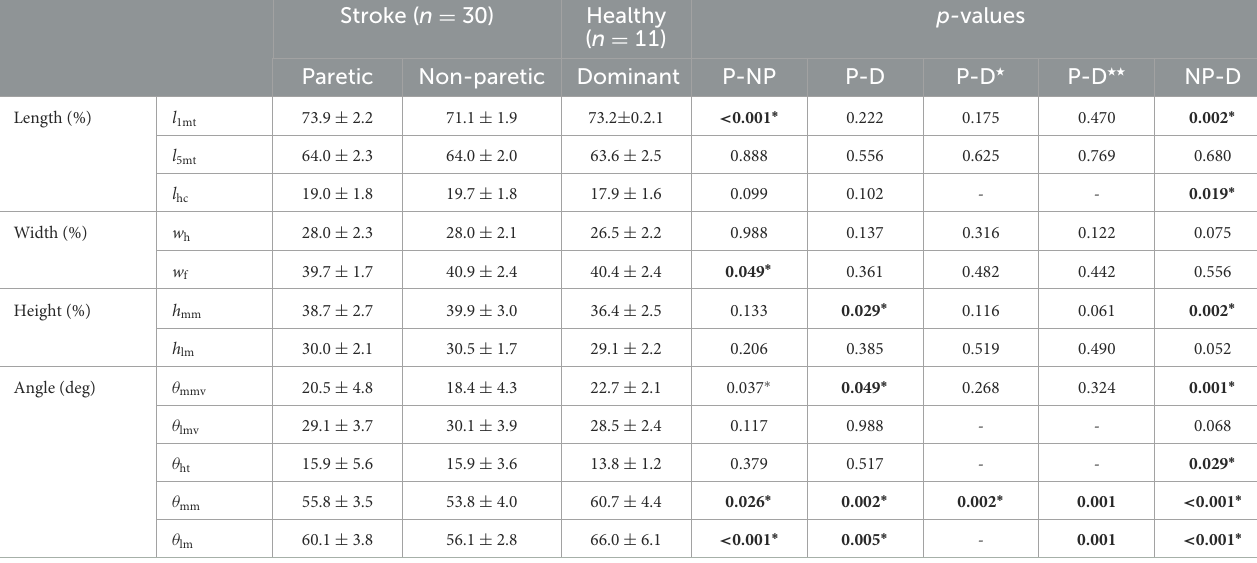
TABLE 1 3D ankle anthropometric measurements ( N = 41).